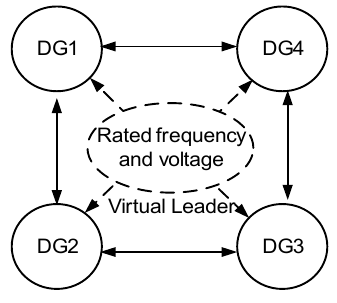
Figure 6. Diagraph with a virtual leader.